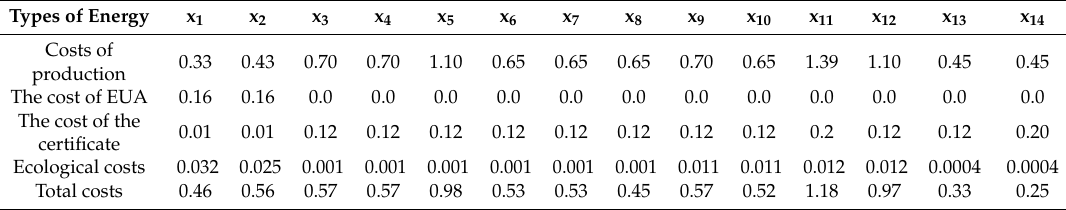
Source: Own study based on the model.